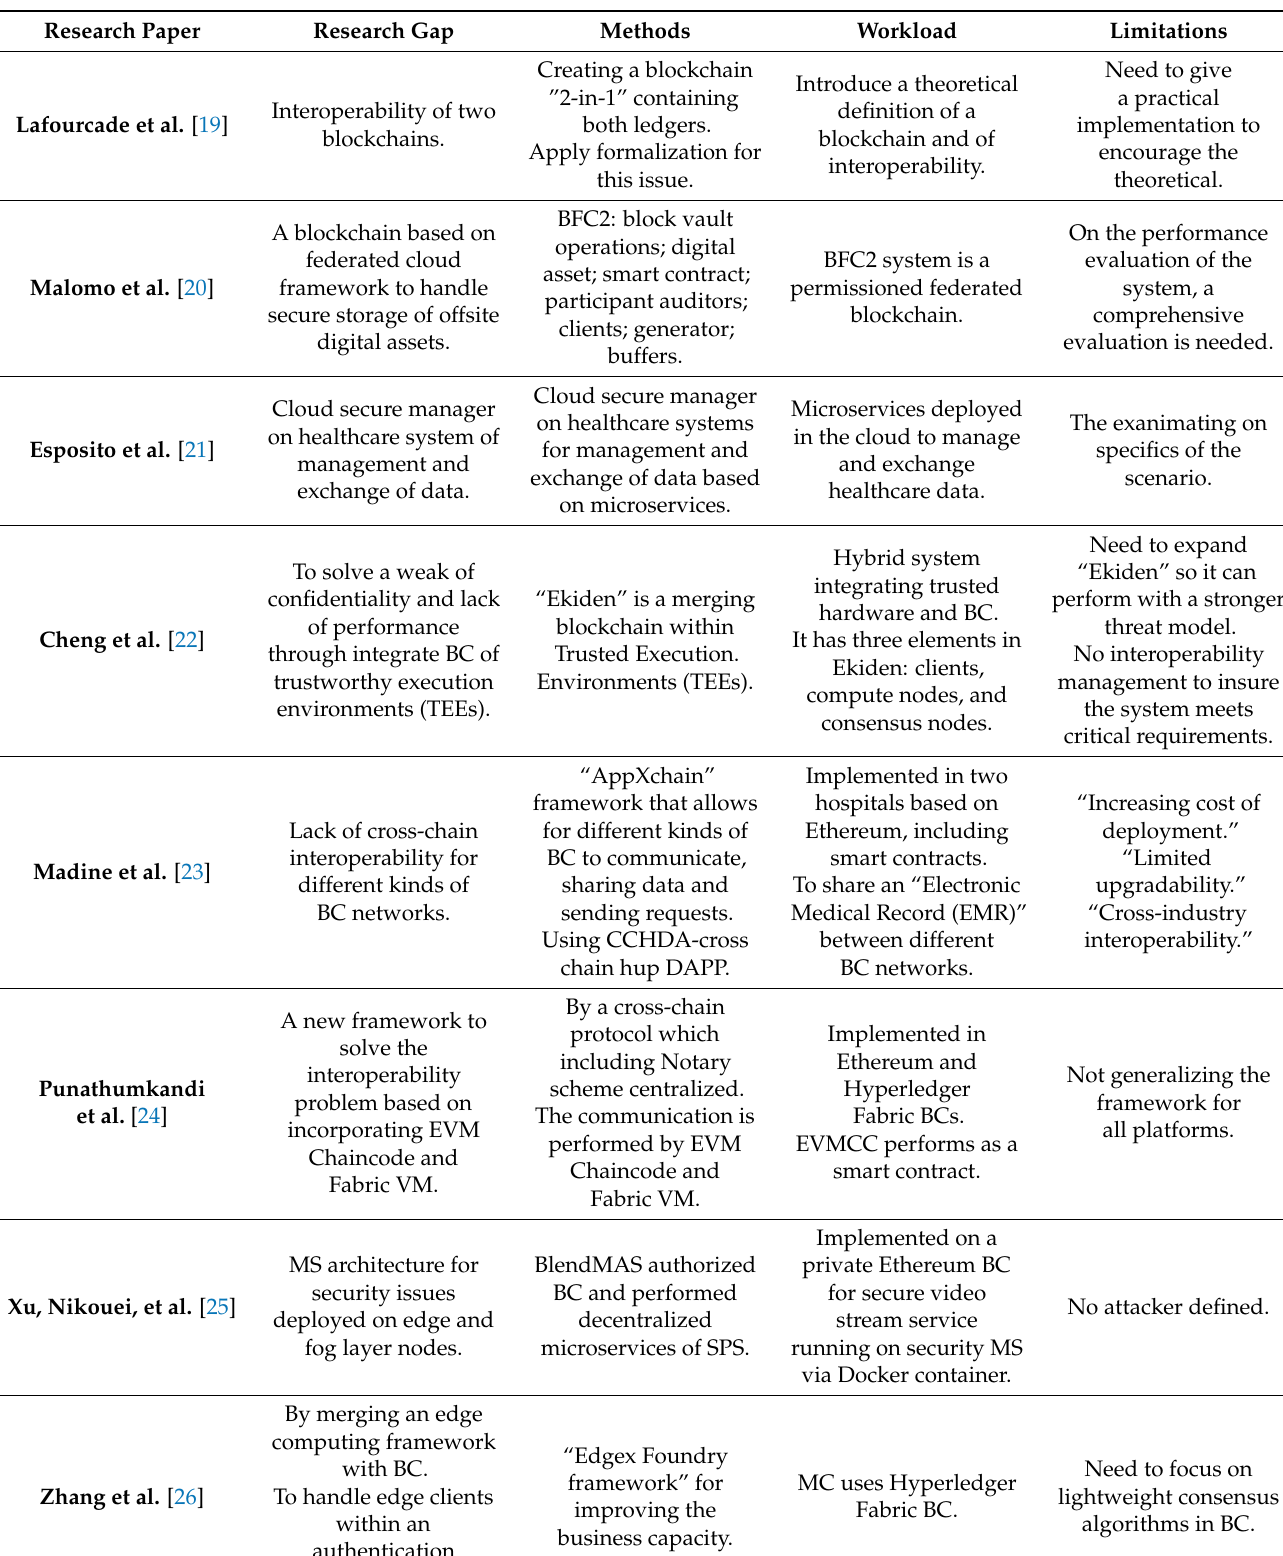
Table 1. Comparative analysis of related